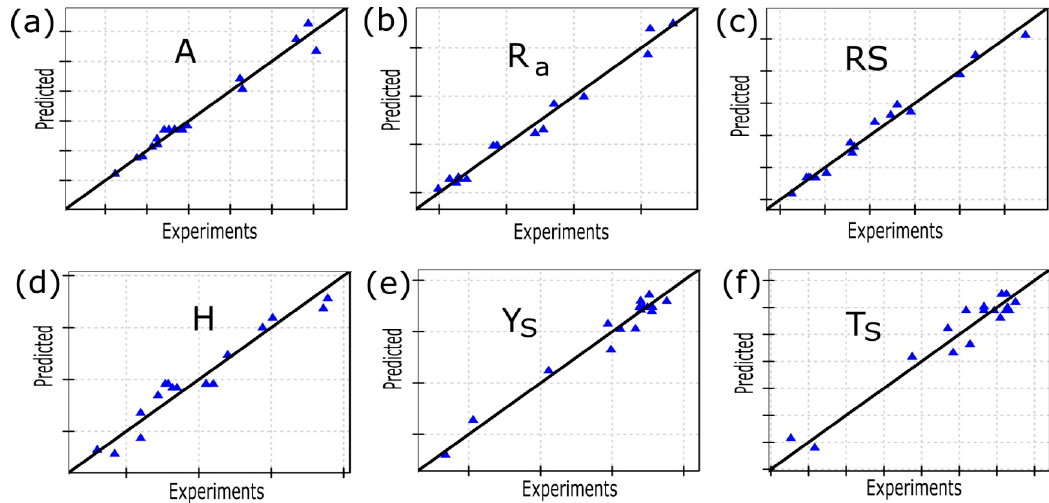
Figure 9. Scatter diagram of: ( a ) area ( A ), ( b ) roughness ( R a ), ( c ) residual stress (RS), ( d ) hardness ( H ), ( e ) yield stress (YS) and ( f ) tensile strength (TS).